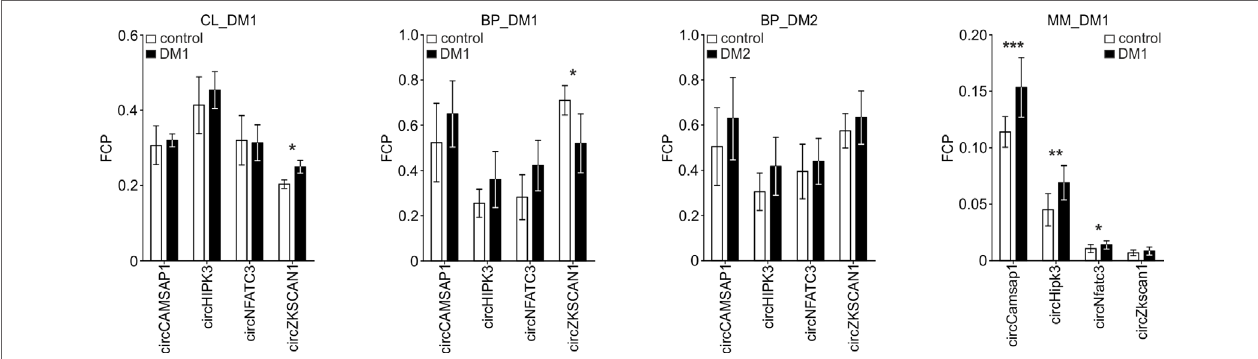
FIGURE 2 | Comparison of circCAMSAP1, circHIPK3, circNFATC3, and circZKSCAN1 levels in DM and control samples. The tested sample sets are indicated above the graphs. The values indicated by white or black bars are the averaged fraction of circular particles (FCPs) calculated for either control or DM samples, respectively. The whiskers represent the standard deviation (SD) values. The differences in circRNA levels were compared with t -tests, and the asterisks represent the following significance levels: * p < 0.05; ** p < 0.01; *** p < 0.001. The exact p -values, SD values, and numbers of samples analyzed are indicated in Table S3 .